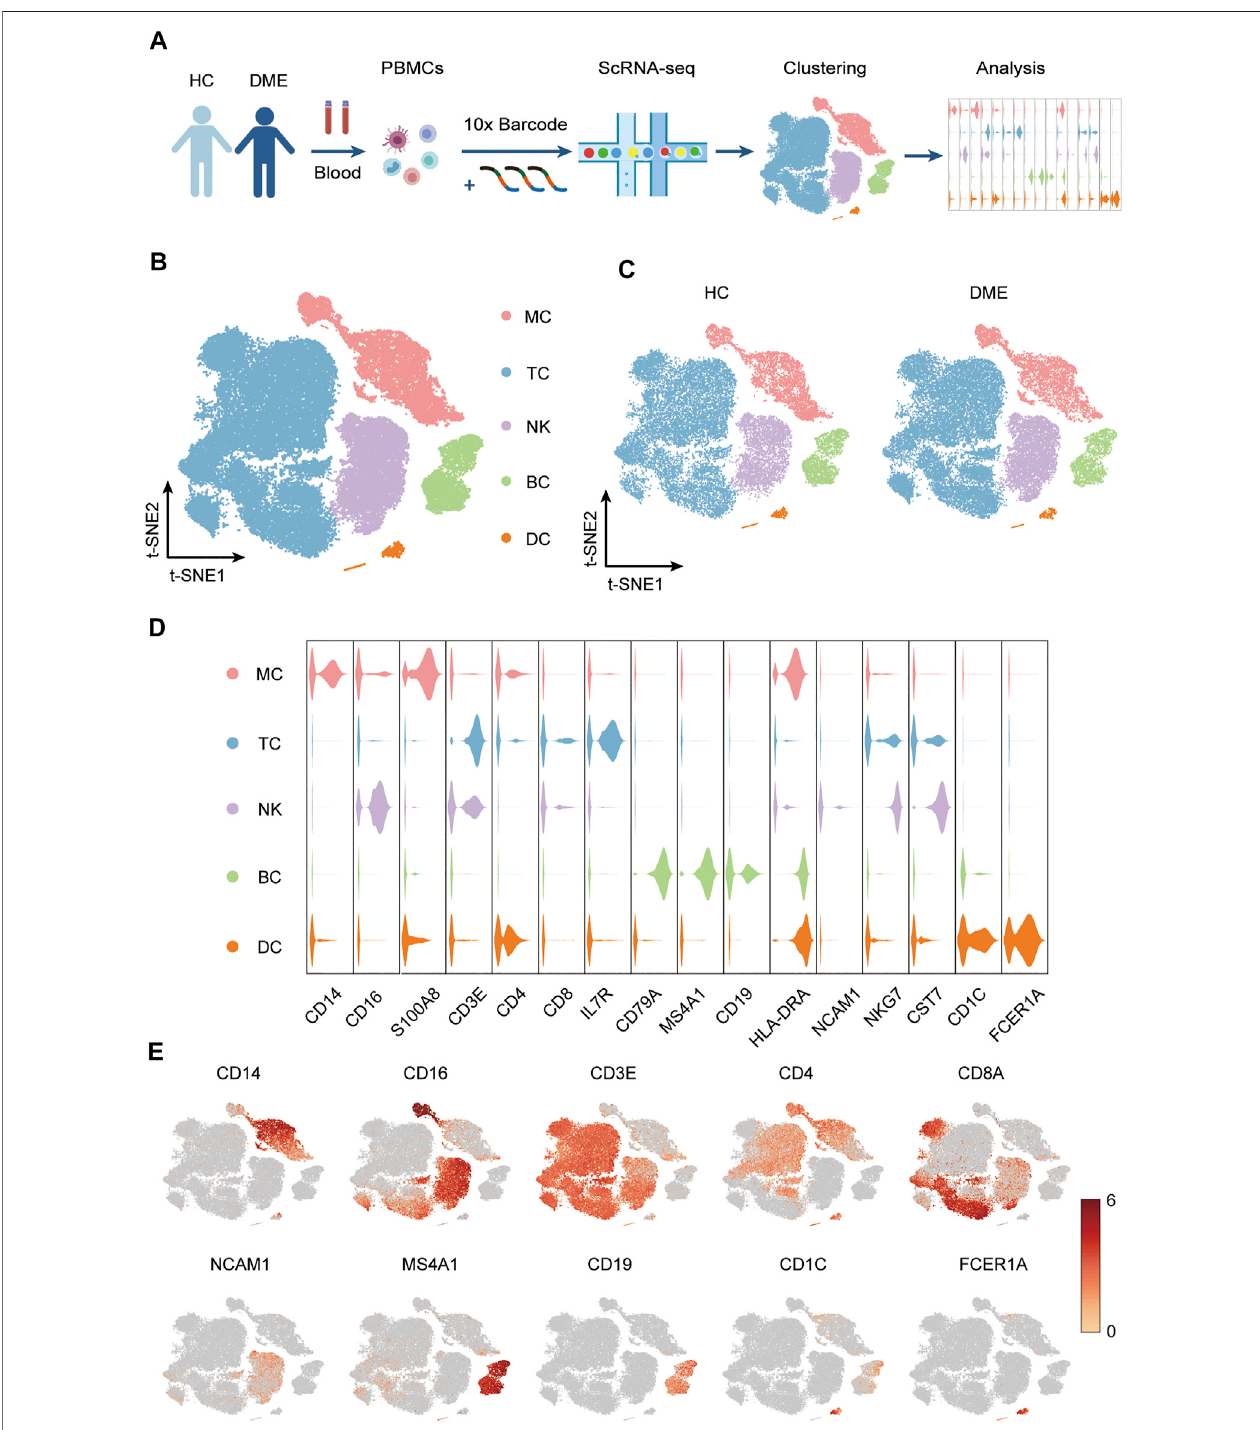
FIGURE 1 | Experimental approach and characterization immune cell clusters from scRNA-seq data. (A) Experimental outline showing PBMC collection and scRNA-seq data analysis. (B) T-sne plot of major immune cell clusters in PBMCs. Cell types are labeled with colors as indicated. Monocytes (MC); T cells (TC); NK cells (NK); B cells (BC) and dendritic cells (DC). (C) T-sne plot of cell clusters in HC and DME respectively. Cell types are labeled with colors as indicated. HC: health control; DME: diabetic macular edema. (D) Violin plot of major immune cell clusters in PBMCs, clustered by their relative expression of the cell type-speci fi c markers. Monocytes (MC); T cells (TC); NK cells (NK); B cells (BC) and dendritic cells (DC). (E) The feature plot showing the expression of representative markers in each cluster.